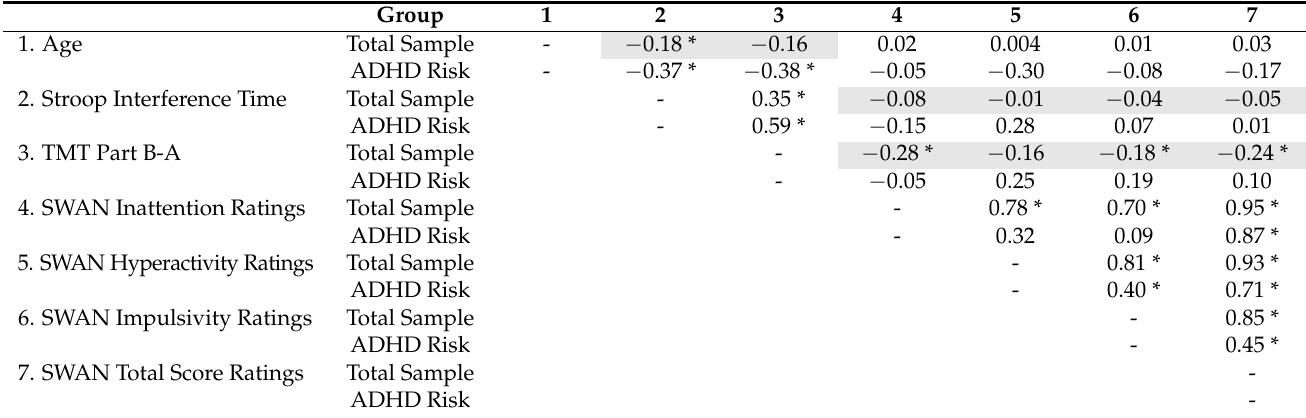
Table 4. Correlations between age, EF tasks and parent reports of impulse and attention regulation among